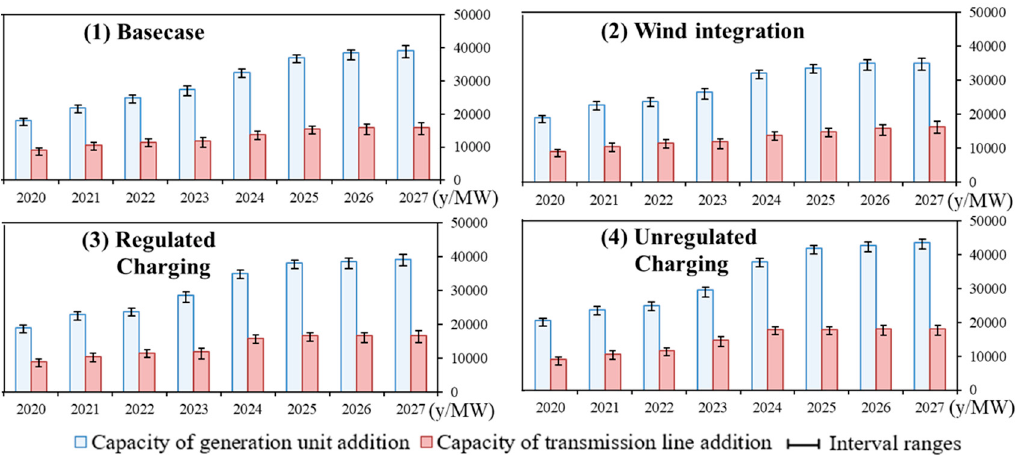
Figure 4. Annual accumulated installed capacity and its interval range for each scenario